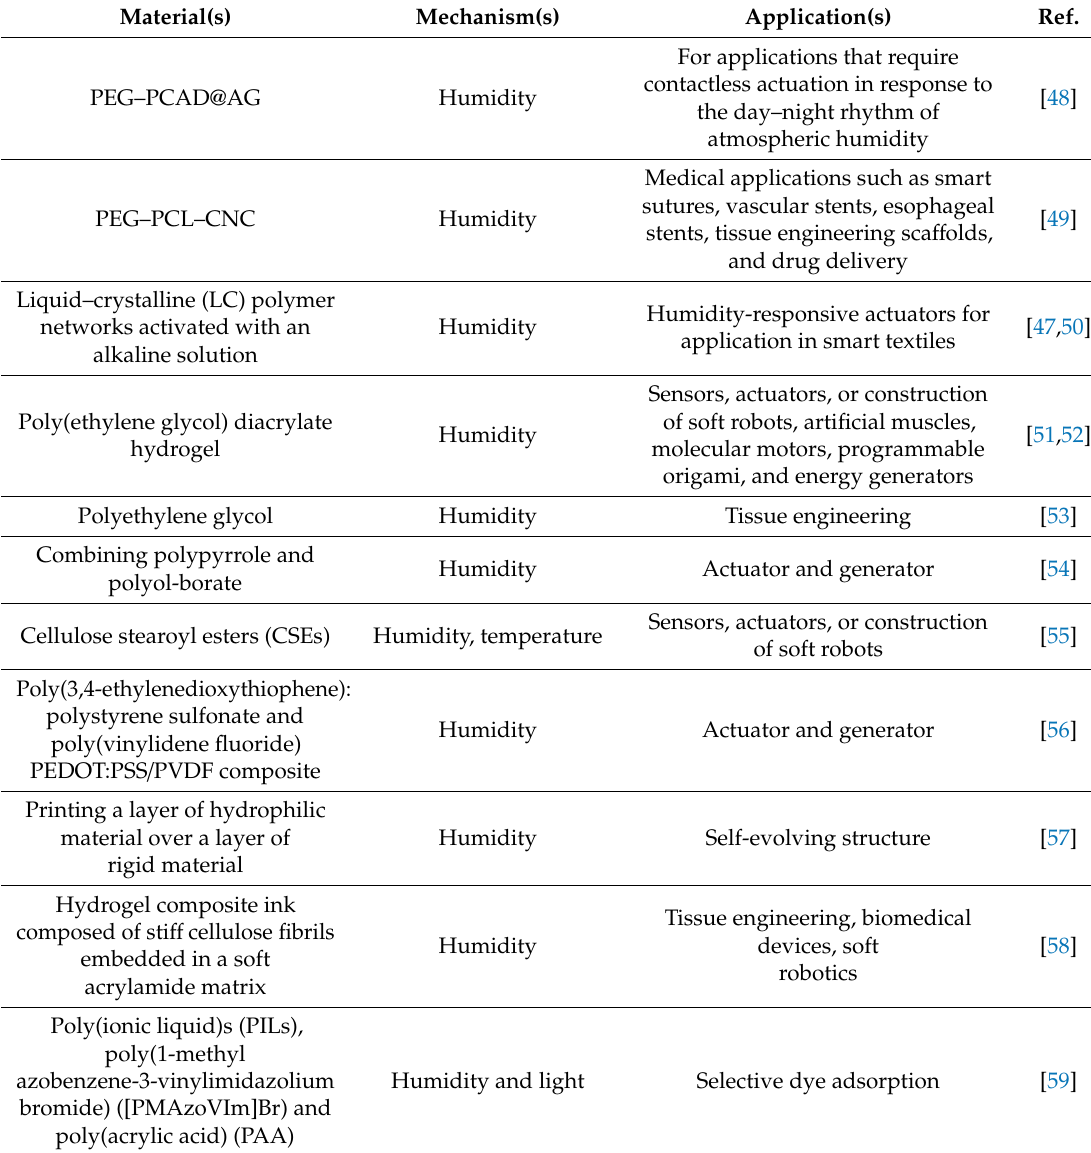
Table 1. Overview of the experiments on 4D (bio-)printing and other manufacturing approaches using humidity as a predefined